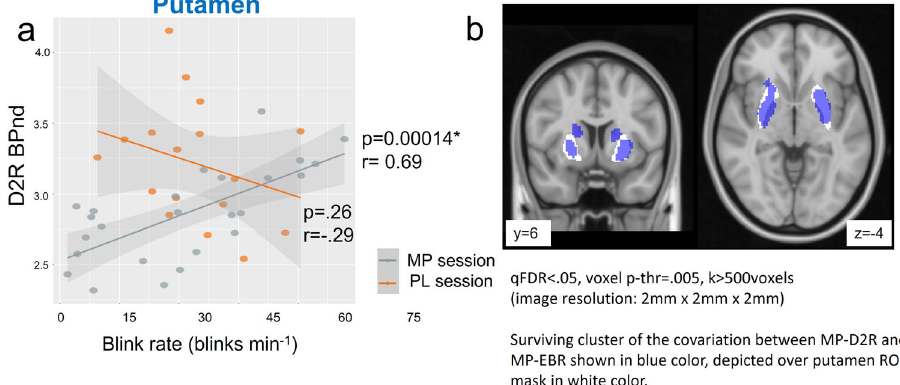
Fig. 2 Putamen D2R BPnd and EBR relationship. a Regression plots for D2R availability (BPnd) measures obtained after placebo (PL-D2R) and after methylphenidate (MP-D2R) in the putamen ROI with eye blink rates for measures after placebo (PL-EBR) and after MP (MP-EBR), shaded area indicates 95% Con fi dence Interval (CI), each points represents a value from each participant. Orange color indicates PL session, and gray color indicates MP session. b Voxel-wise regression (qFDR corrected) showing the surviving cluster of the covariation between MP-D2R and MP-EBR in blue in the SPM model, depicted over putamen ROI mask shown in white. Participants with higher MP-D2R in putamen had higher EBR with MP (n(MP) = 25, n(PL) = 17) whereas PL-D2R measures were not associated with PL-EBR. qFDR corrected voxel values are shown.